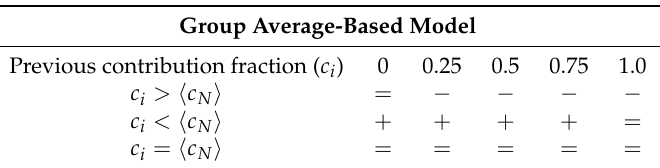
Table 2. In the payoff group average model, the agent decreases (increases) its contribution when the latter is larger (smaller) than the average contribution of the group. It remains the same when these two quantities are equal. The amount of decrease (increase) is a random value chosen in { 0.1,0.2, 0.3 } .